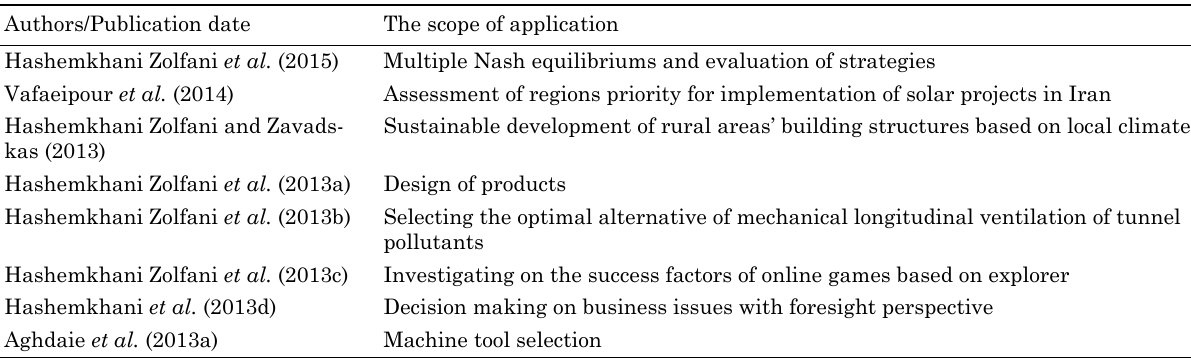
Table 2. Developments of decision making models based on SWARA